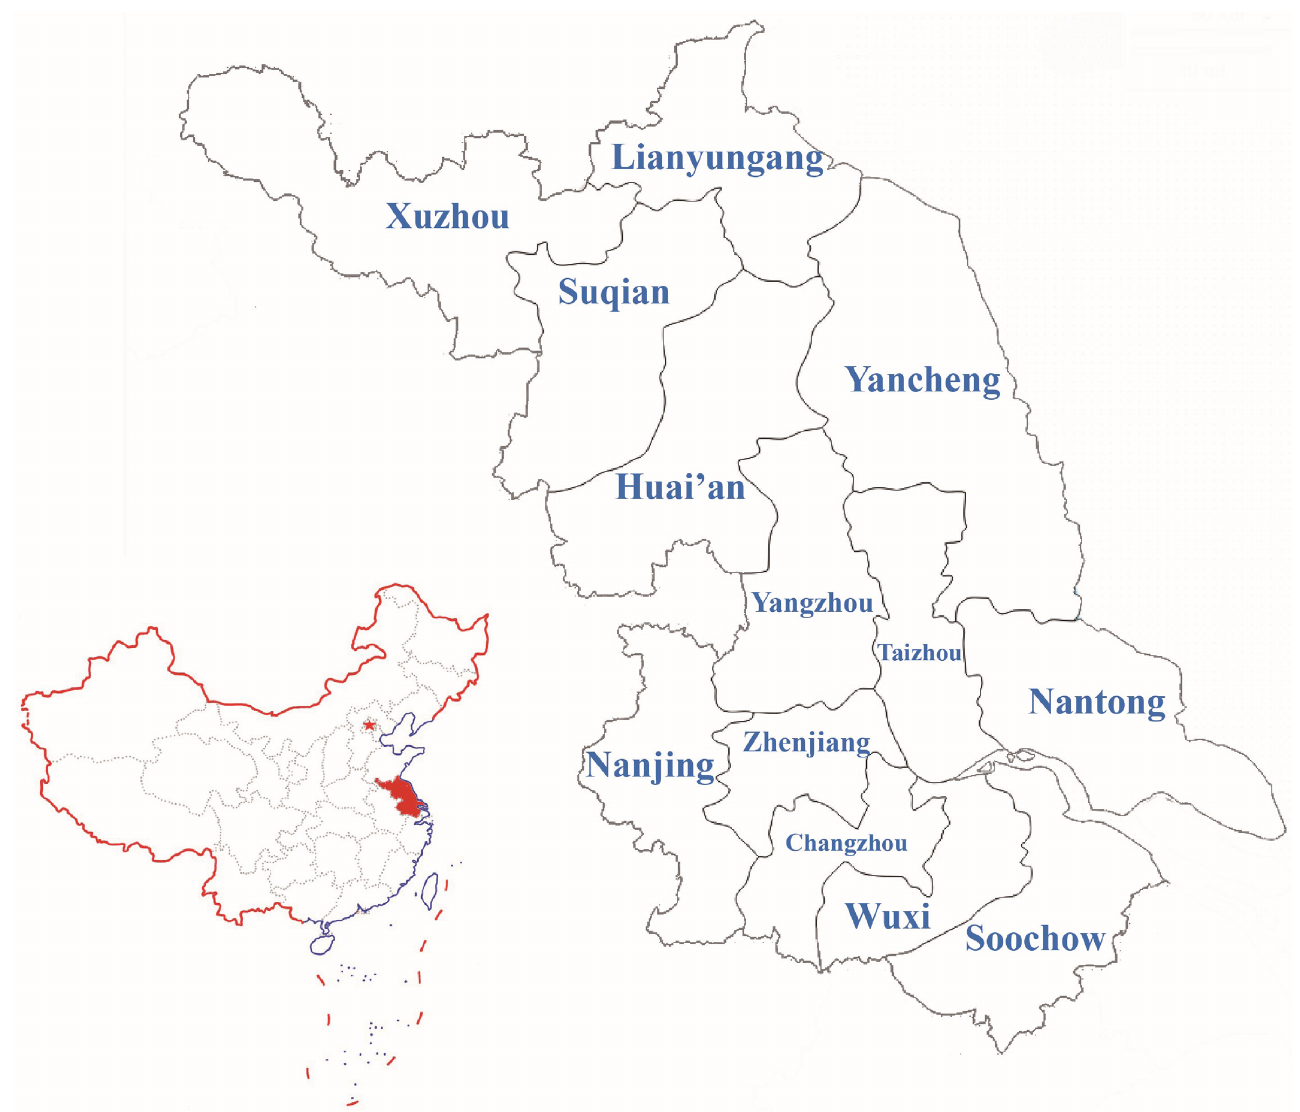
Fig 1. The geographic location of Jiangsu province in the scale of China. The names of 13 prefecture-level cities were labelledin the map. The red five-pointedstar representedBeijingCity.